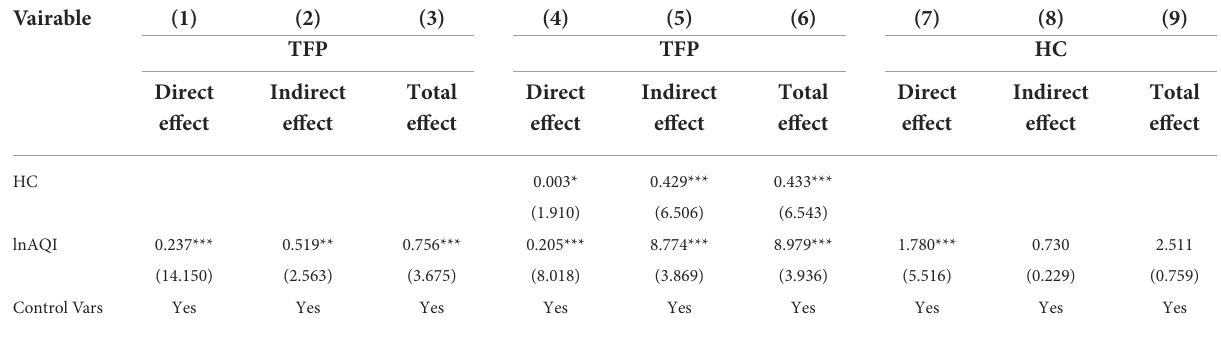
TABLE 16 Decomposition effect of human capital.